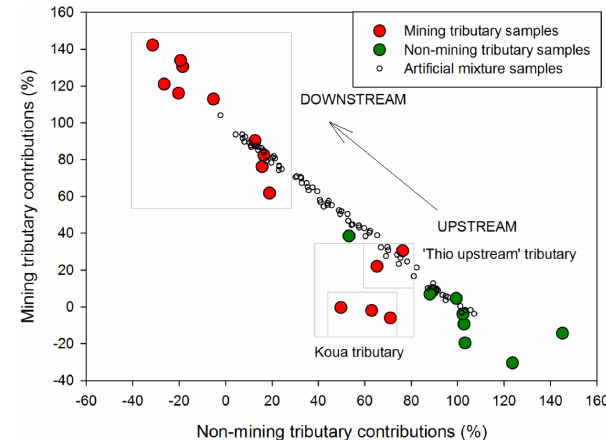
Figure 11. Relative compositions of mining and non-mining sources estimated by the FDVS-PLSR models applied to the indi- vidual source sediment